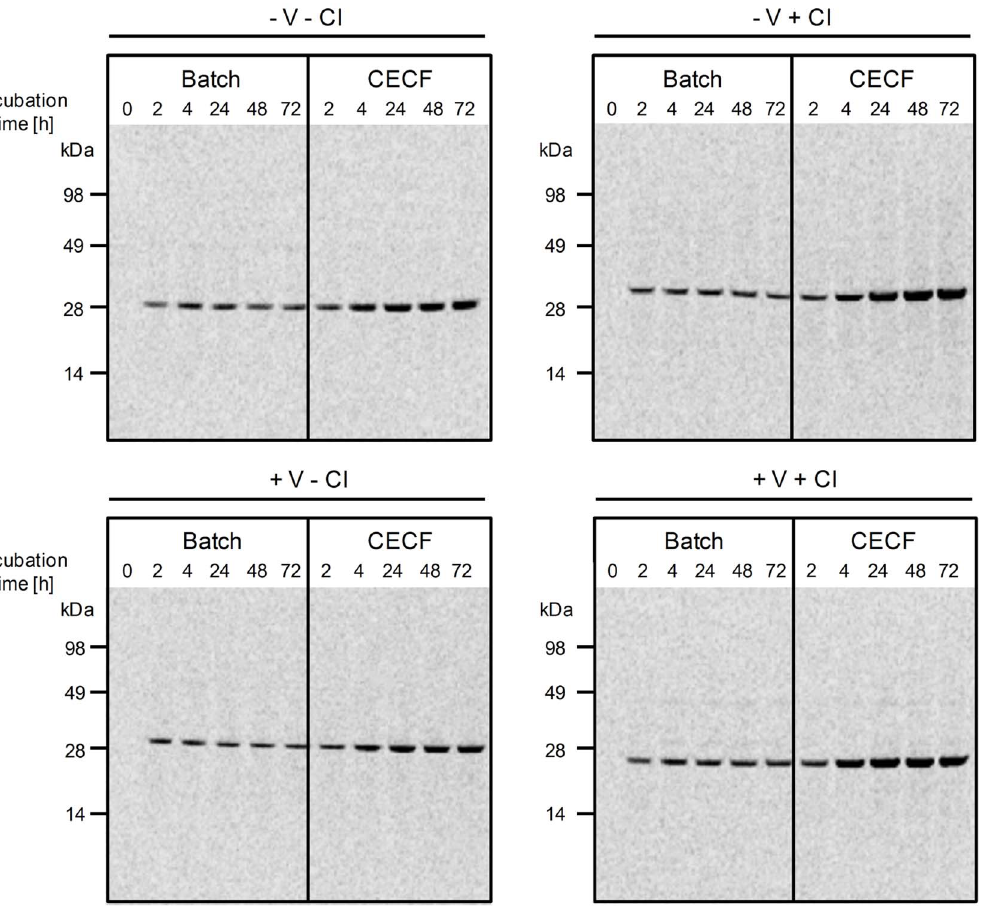
Figure 2. Time course of 14 C-leucine labeled eYFP synthesized in batch and CECF mode. Cell-free reactions using insect lysate were carried out in the presence ( + ) and absence ( 2 ) of insect vesicles (V) and caspase inhibitor (CI). Translation mixtures were analyzed by SDS-PAGE and autoradiography. Cell-free synthesized eYFP shows a migration pattern corresponding to its expected molecular mass (calculated molecular mass =29 kDa).